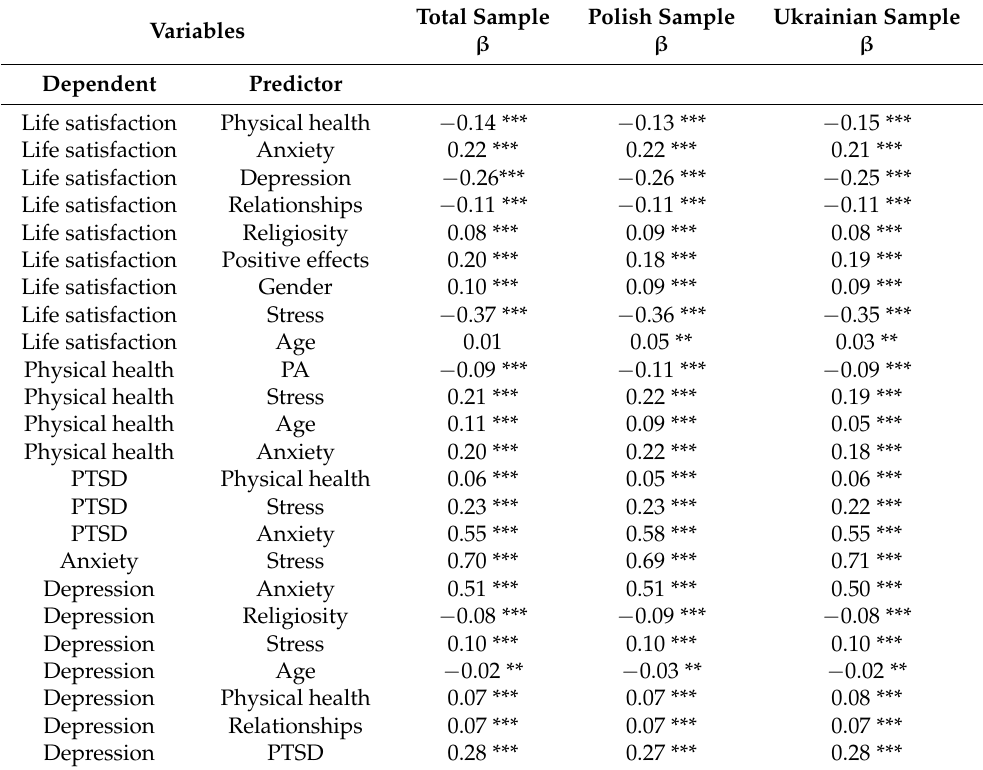
Table 7. Standardized regression weights for path model in the total sample ( N = 3230), Polish group ( n = 1581) and Ukrainian group ( n = 1649) of university students.